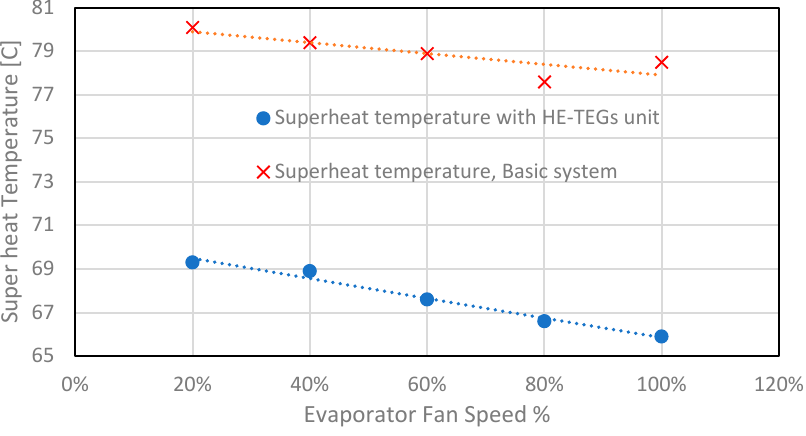
Figure 5. Variation of superheat temperature with evaporator fan speed with and without HE-TEGs unit.